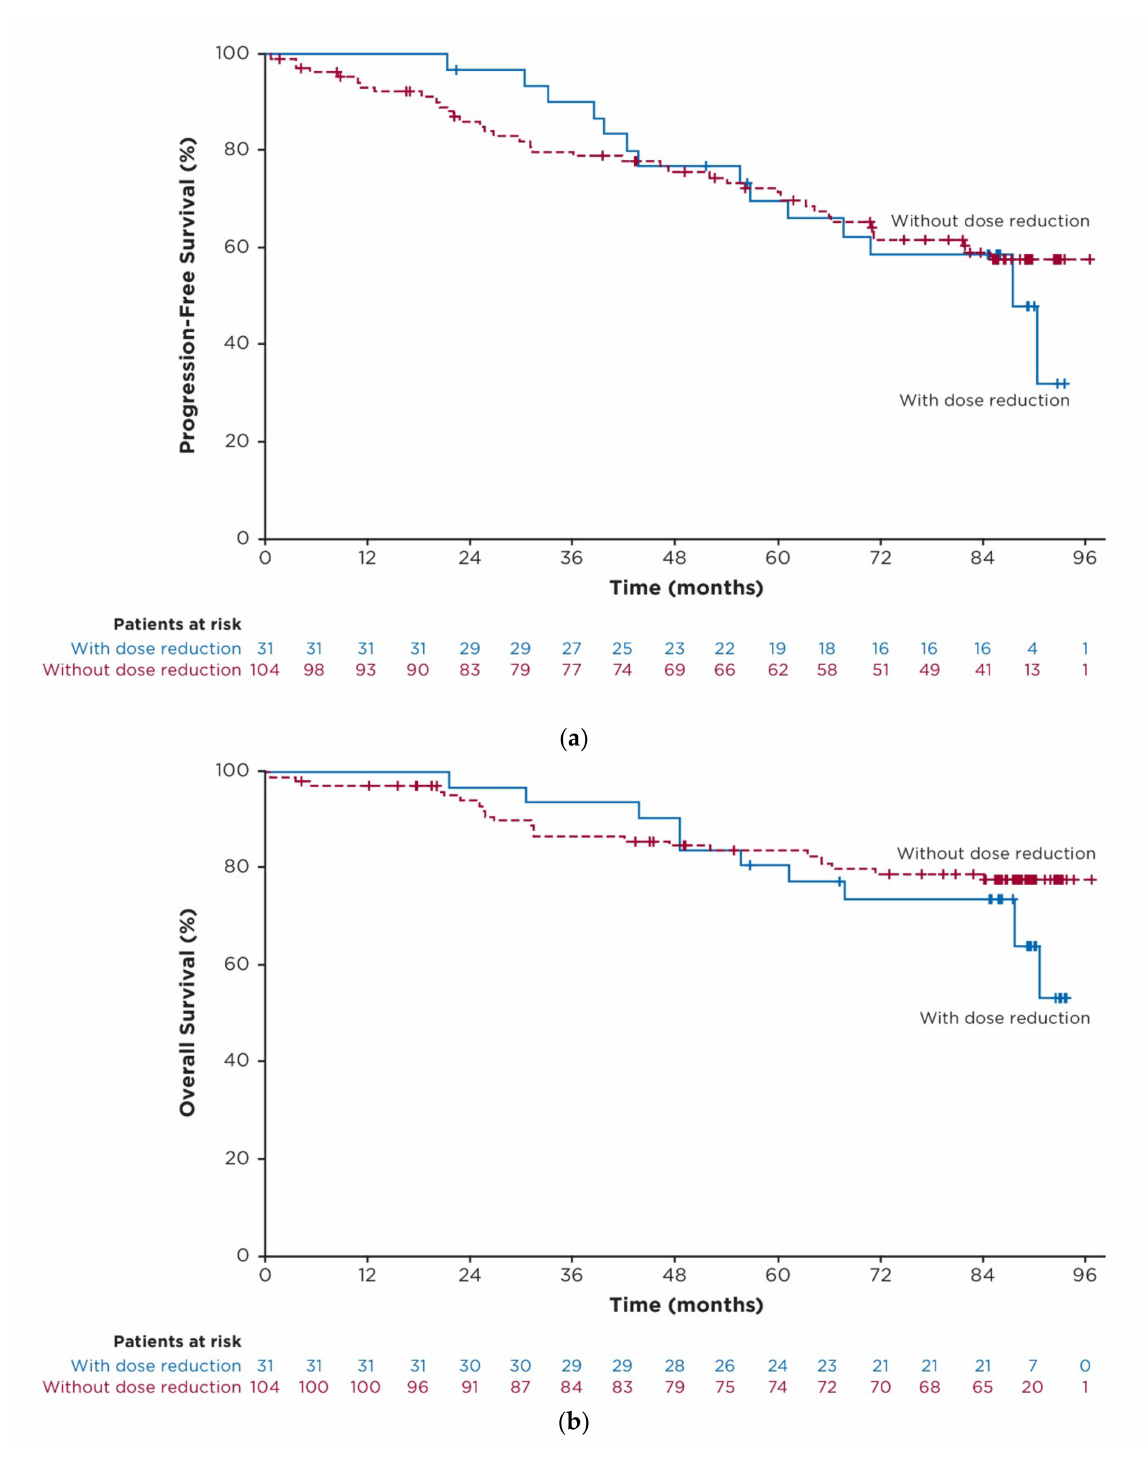
Figure 4. Efficacy in patients with and without dose reductions because of AEs in the overall popula- tion of ibrutinib-treated patients. ( a ) Kaplan-Meier curve of investigator-assessed PFS; ( b ) Kaplan- Meier curve of OS. Abbreviations: AE, adverse event; OS, overall survival; PFS, progression-free